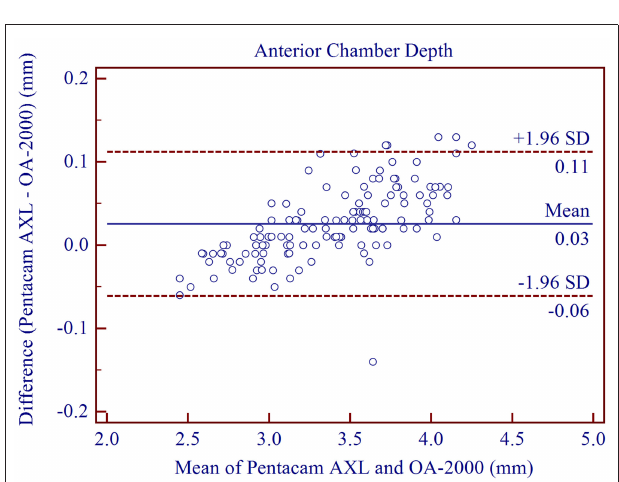
(ICC = 0.995) and Güler et al. (20) (CoV = 0.11%, ICC